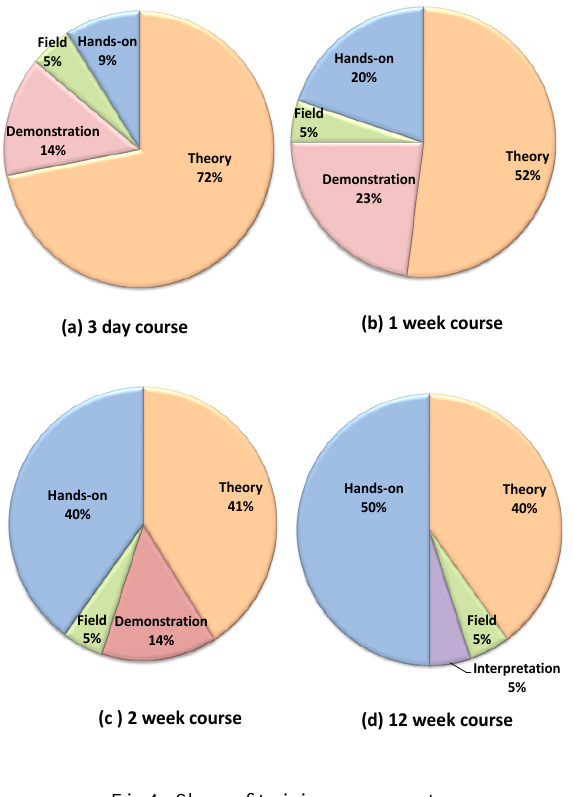
Fig 4. Share of training